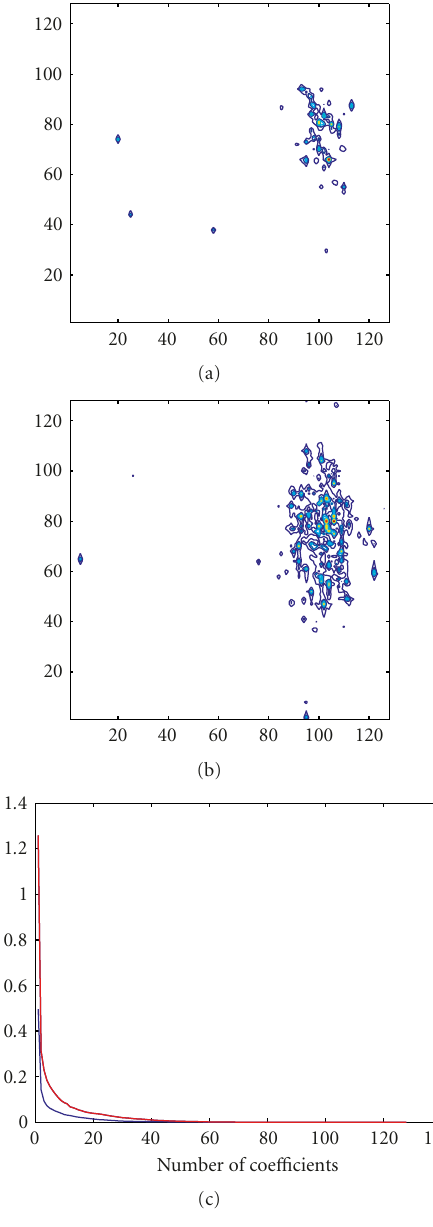
Figure 3: (a) Uncrowded and (b) crowded spectra; (c) rapid decay of approximation error for symmlet with 8 vanishing